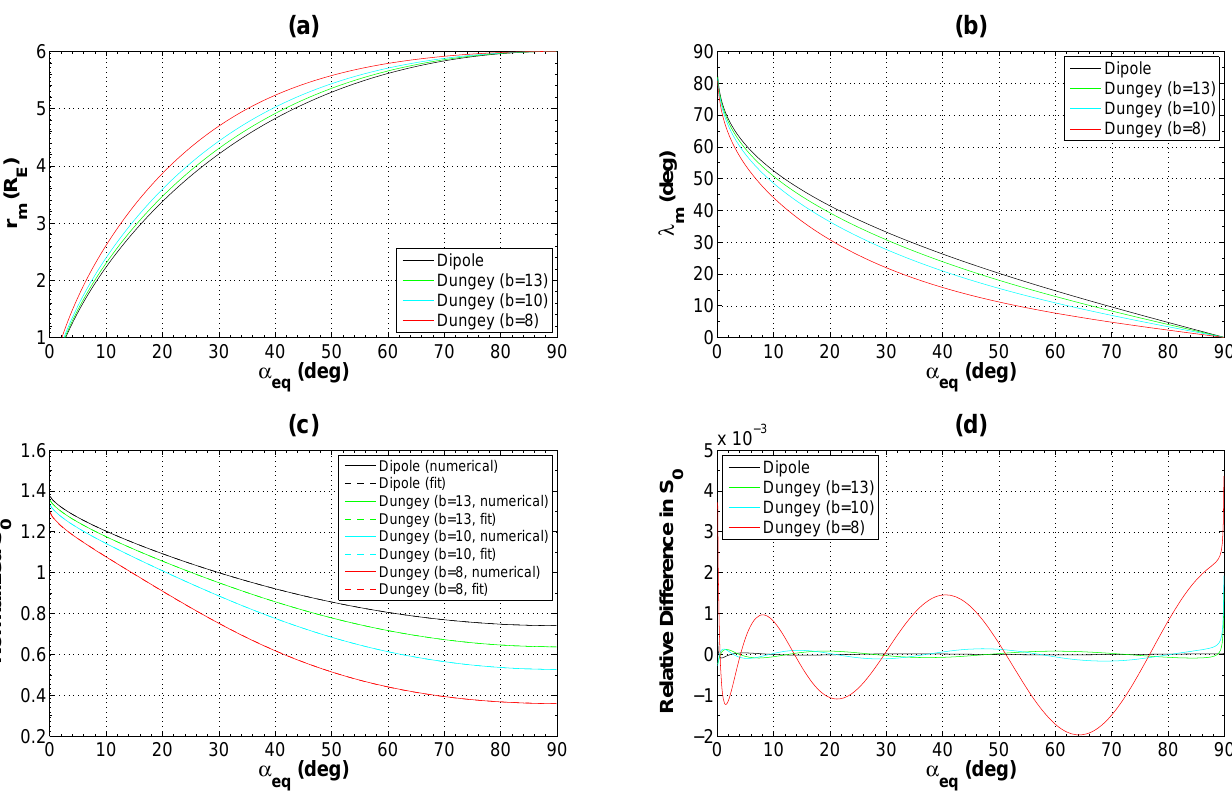
Fig. 2. (a) mirror radial distance r m and (b) mirror latitude λ m as a function of α eq for r 0 = 6 R E with b / R E = ∞ (dipole), 13, 10 and 8. (c) Solid curves: normalized bounce period related term S 0 calculated numerically using Eq. (31), dashes curves: approximate representations of S 0 by a fifth-order polynomial of p sin α eq , and (d) the errors associated with the fitted polynomials, for the indicated four cases of b